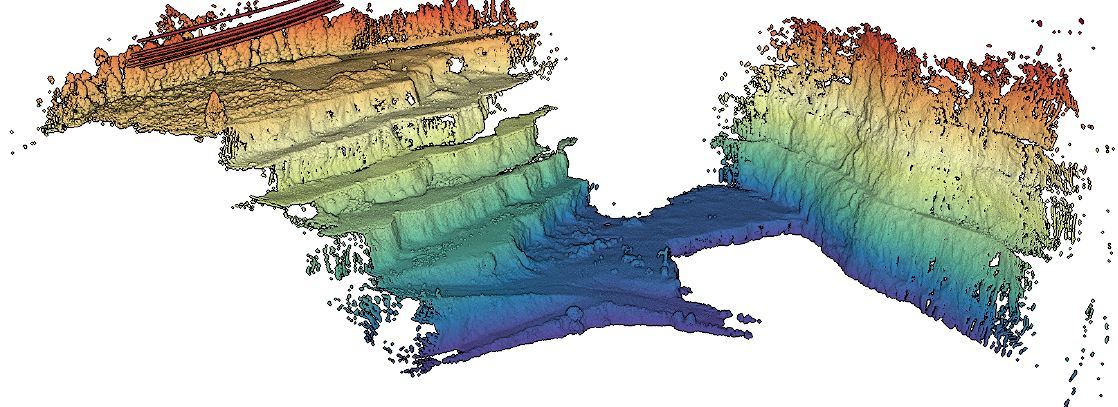
Figure 12. Complete point cloud of the Malaposta quarry mapping survey.